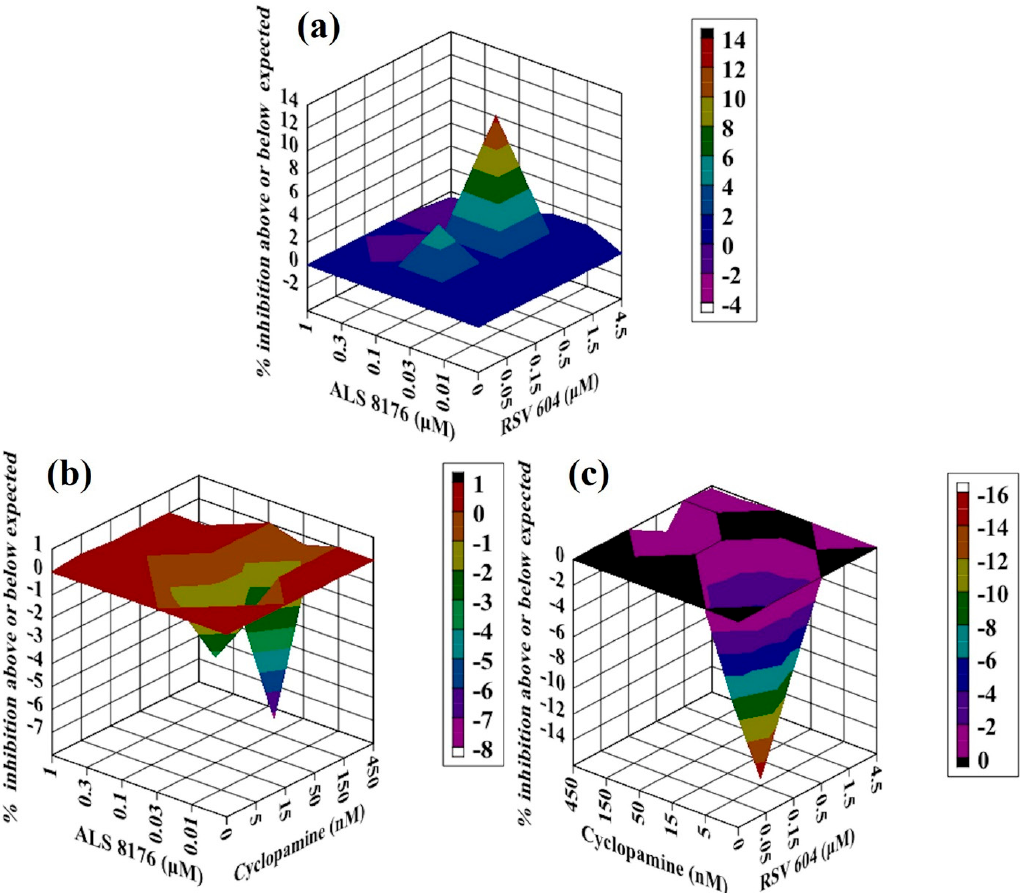
Figure 6. Analysis of compound interactions between RdRp inhibitors. HEp-2 cells infected with RSV–Luc were subjected to serial dilutions of ALS8176 (( a , b ); 0.3–30 nM), RSV604 (( b , c ); 0.05–4.5 µM), or CPM (( a , c ); 5–450 nM) in a checkerboard method, and results were obtained via a luciferase activity reduction assay ( a – c ). Data shown were obtained using Macsynergy II program at 95% confidence level and plotted with Delta Graph, and values on the Z-axis represent the mode of interaction between two selected compounds (>0, synergistic effect; <0, antagonistic effect; 0, additive effect). All data points represent averages of three measurements from three experiments.